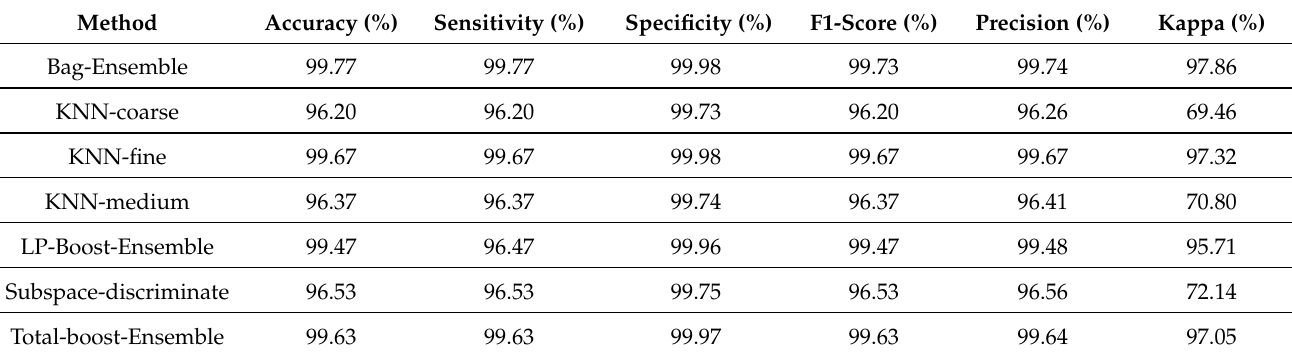
Table 7. Classification validation accuracy of tenfold validation using self-activated